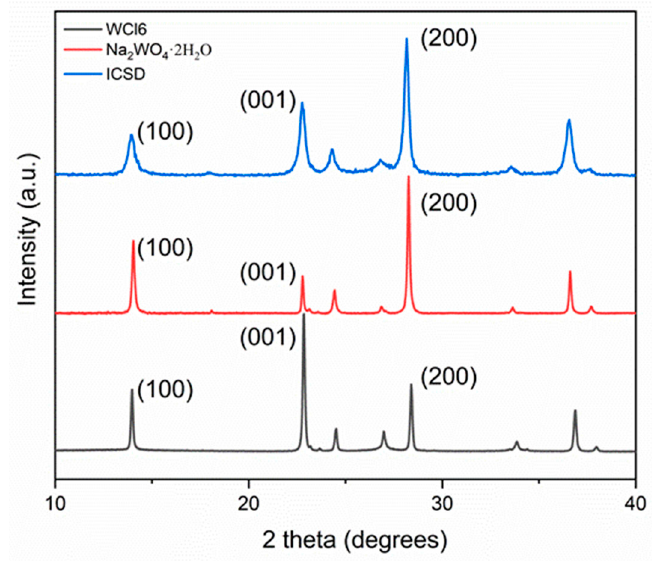
Figure 1. XRD spectra of the standard reference pattern (ICSD 32001 from Ref. [3]) for the hexagonal polymorph of tungsten trioxide ( h - WO 3 ) in comparison to the h -WO3 samples synthesized in this work using the Na 2 WO 4 · 2 H 2 O and WCl 6 precursors. For the 𝑁𝑎 (cid:2870) WO (cid:2872) ∙ 2𝐻 (cid:2870) 𝑂 sample, the relative intensity of the (100) peak compared